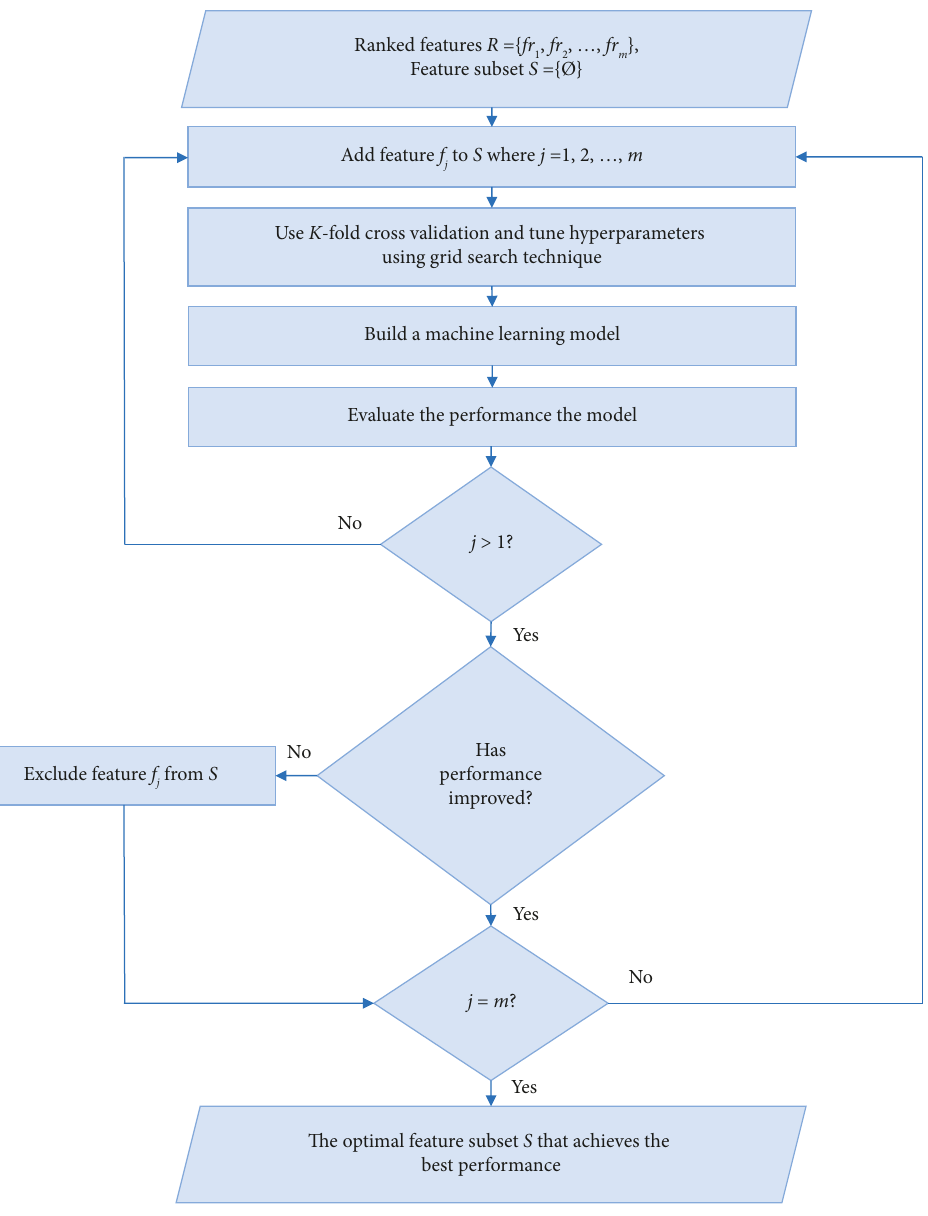
Figure 3: Feature selection and classification